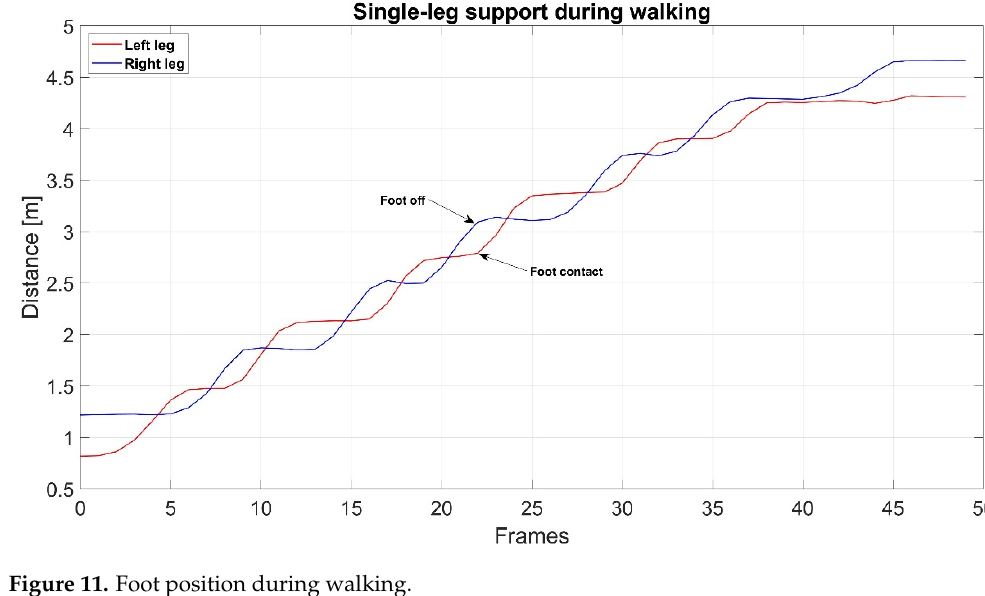
Figure 11. Foot position during walking.